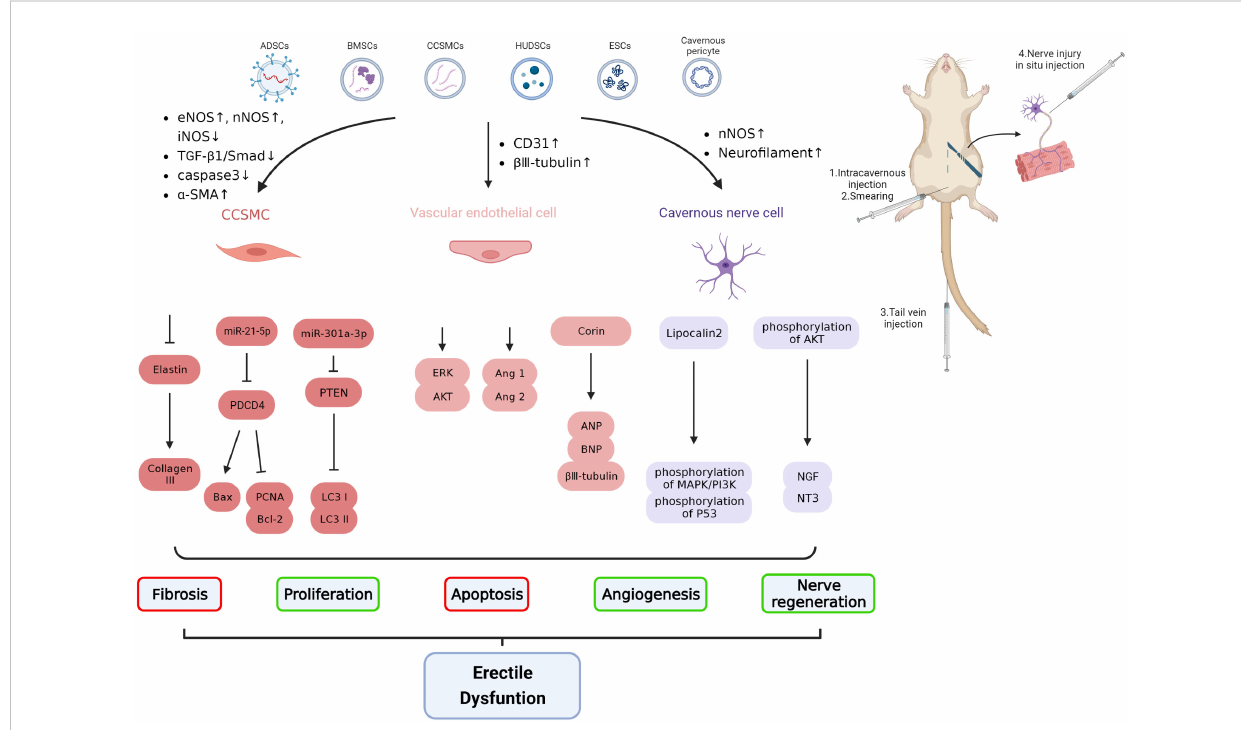
FIGURE 1 Schematic diagram of the molecular mechanism of exosome therapy for ED. CCSMC, corpora cavernosum smooth muscle cell; eNOS: endothelial nitric oxide synthase; nNOS: neuronal nitric oxide synthase; iNOS: inducible nitric oxide synthase; Ang 1, angiotensin 1; Ang 2, angiotensin 2; ANP: atrial natriuretic peptide; BNP: brain natriuretic peptide; TGF- b 1, transforming growth factor- b 1; NT3: neurotrophin 3; NGF, nerve growth